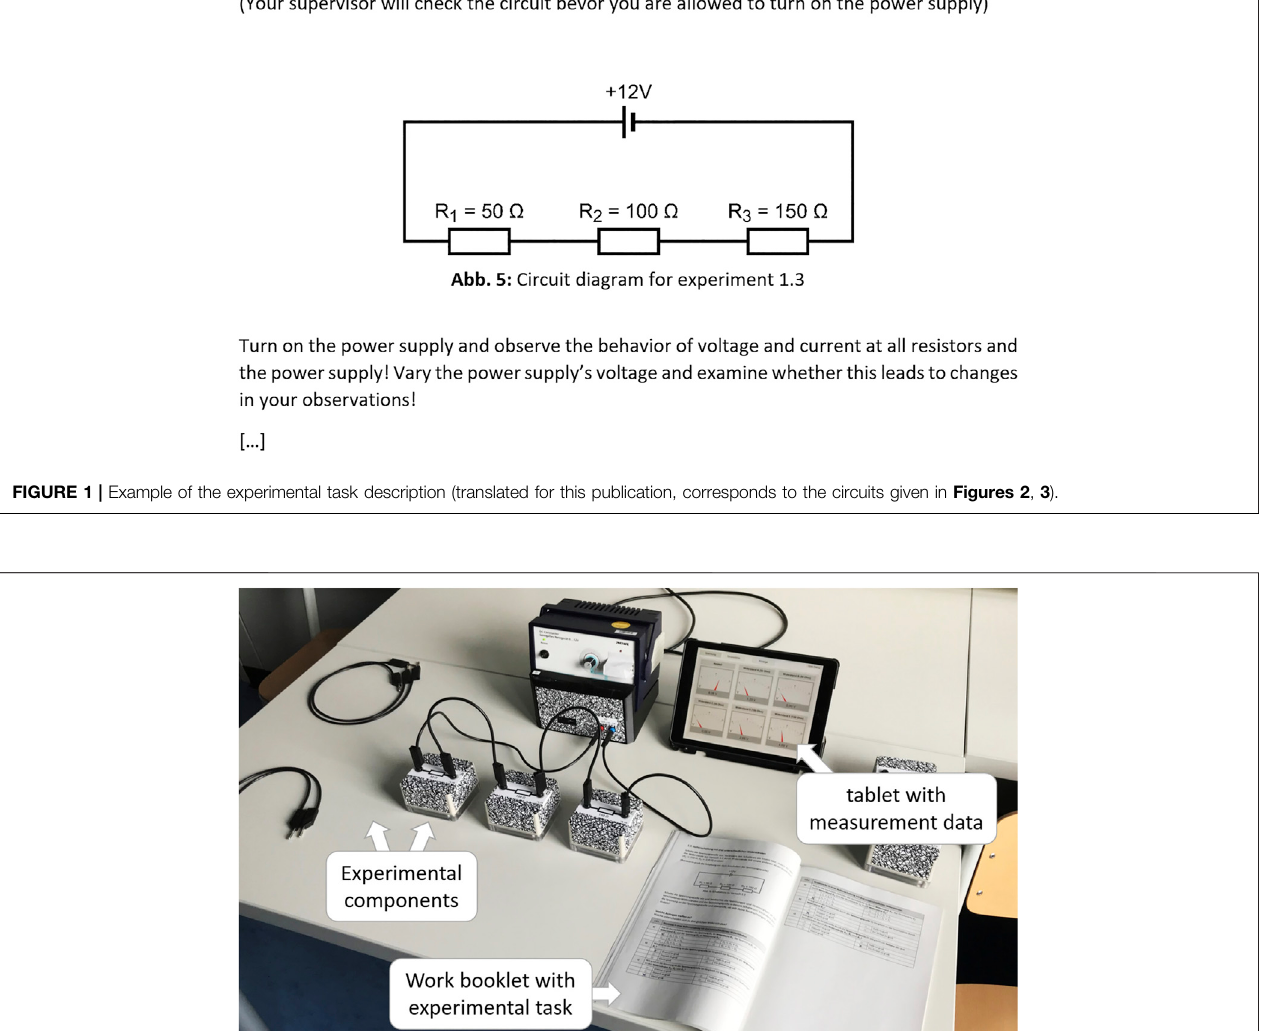
Frontiers in Education |